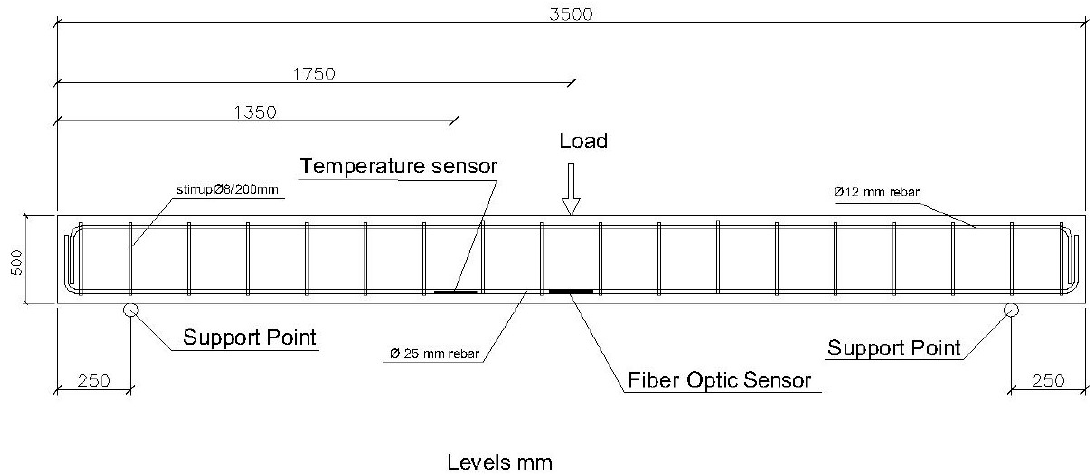
Figure 5. Reinforcement scheme of the 300 × 500 mm beam and application point of the loading steps.